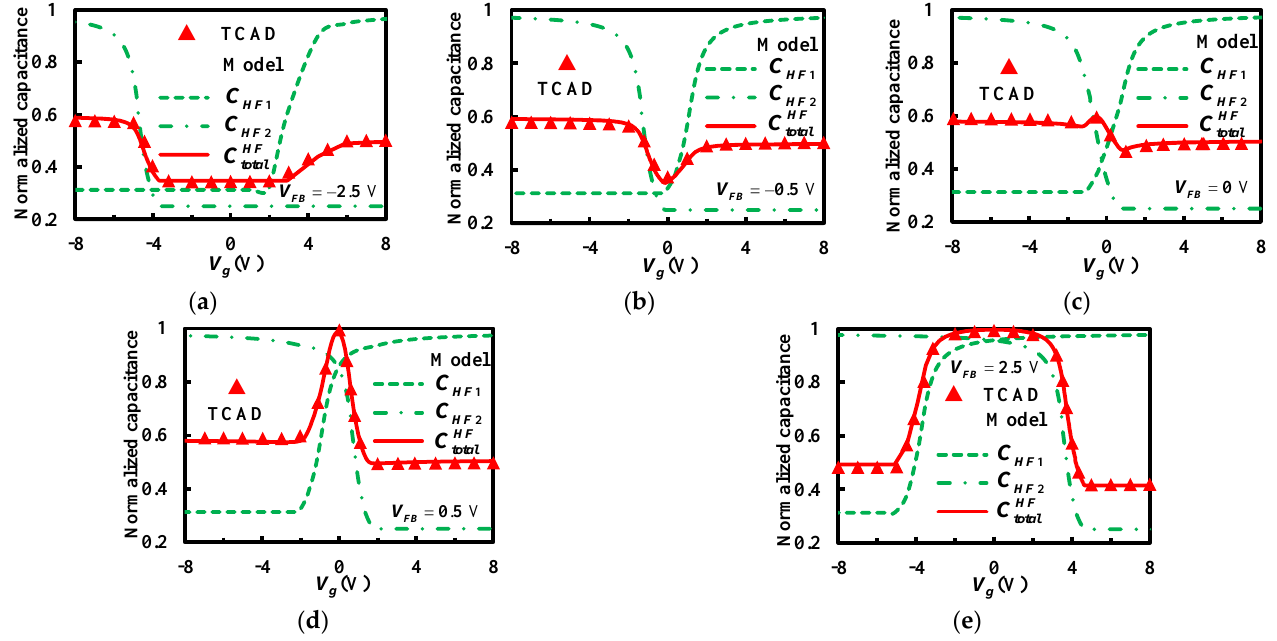
Figure 7. Different high-frequency capacitance – voltage curves of the staked bonding structure. ( a ) V FB = -2.5 V, ( b ) V FB = -0.5 V, ( c ) V FB = 0 V, ( d ) V FB = 0.5 V and ( e ) V FB = 2.5 V.